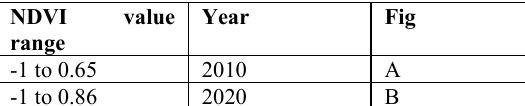
NDVI value Year Fig range -1 to 0.65 2010 A -1 to 0.86 2020